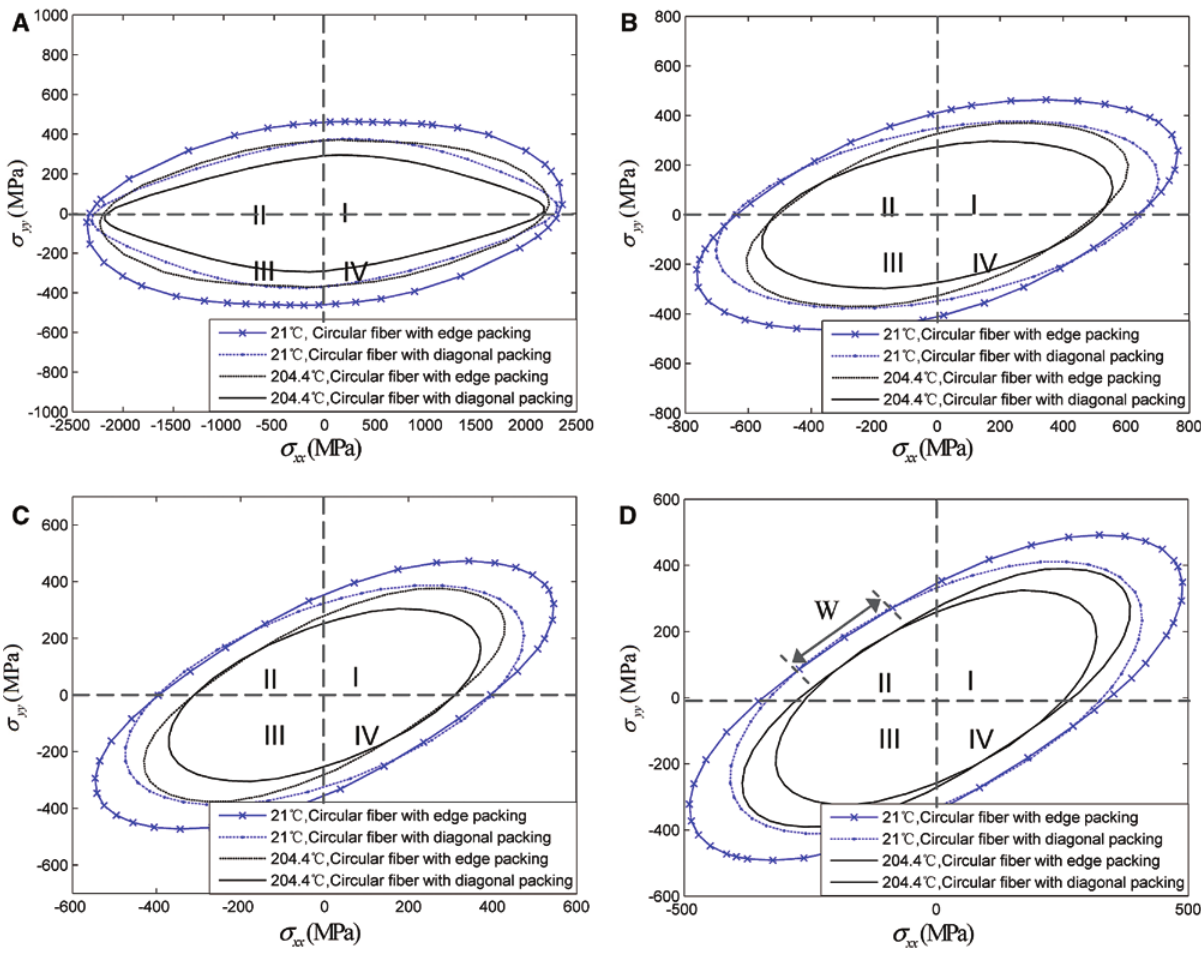
Figure 5 Initial yield surfaces of boron/Al composites with different fiber arrays: (A) 0 ° fiber-reinforced composites, (B) 15 ° fiber-reinforced composites, (C) 30 ° fiber-reinforced composites and (D) 45 ° fiber-reinforced